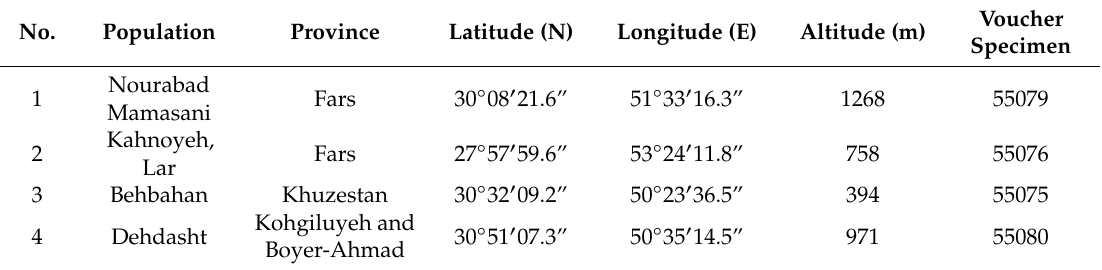
Table 3. Geographical characteristics and voucher specimens of Oliveria decumbens populations from which essential oils were